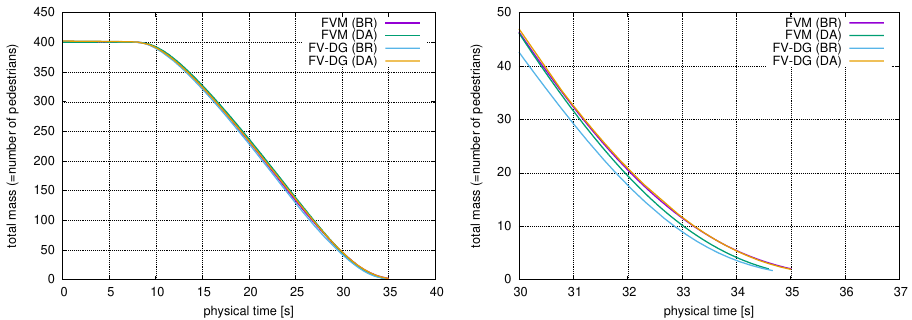
Figure 4. Domain with three obstacles, FV(BR), FV(DA) ( top ) and FV-DG(BR), FV-DG(DA) ( bottom ). Density distribution at time t = 10,15,20 s obtained on the finest meshes.